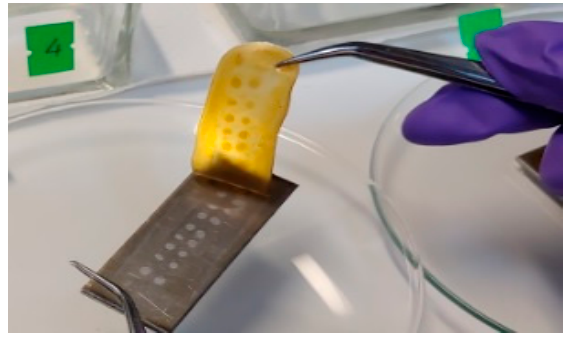
Figure 1. Decontamination of metal surface with